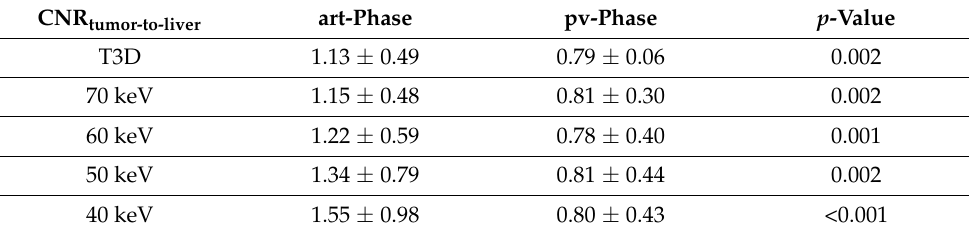
Table 6. Image noise (standard deviation of the psoas muscle).